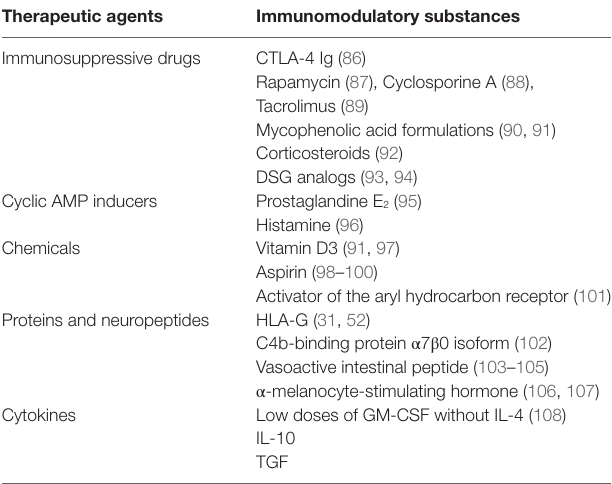
Table 2 | Pharmacologic interventions to induce tolerogenic DCs (tolDCs). Therapeutic